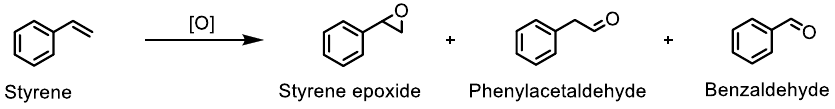
Table 4. Comparison of the surface atomic percentages obtained by XPS for CAT-4-MR and CAT-4-Si with the obtained materials after catalysis: CAT-4-MR-H 2 O 2 , CAT-4-MR-TBHP , CAT-4-Si-H 2 O 2 and CAT-4-Si-TBHP (a) .